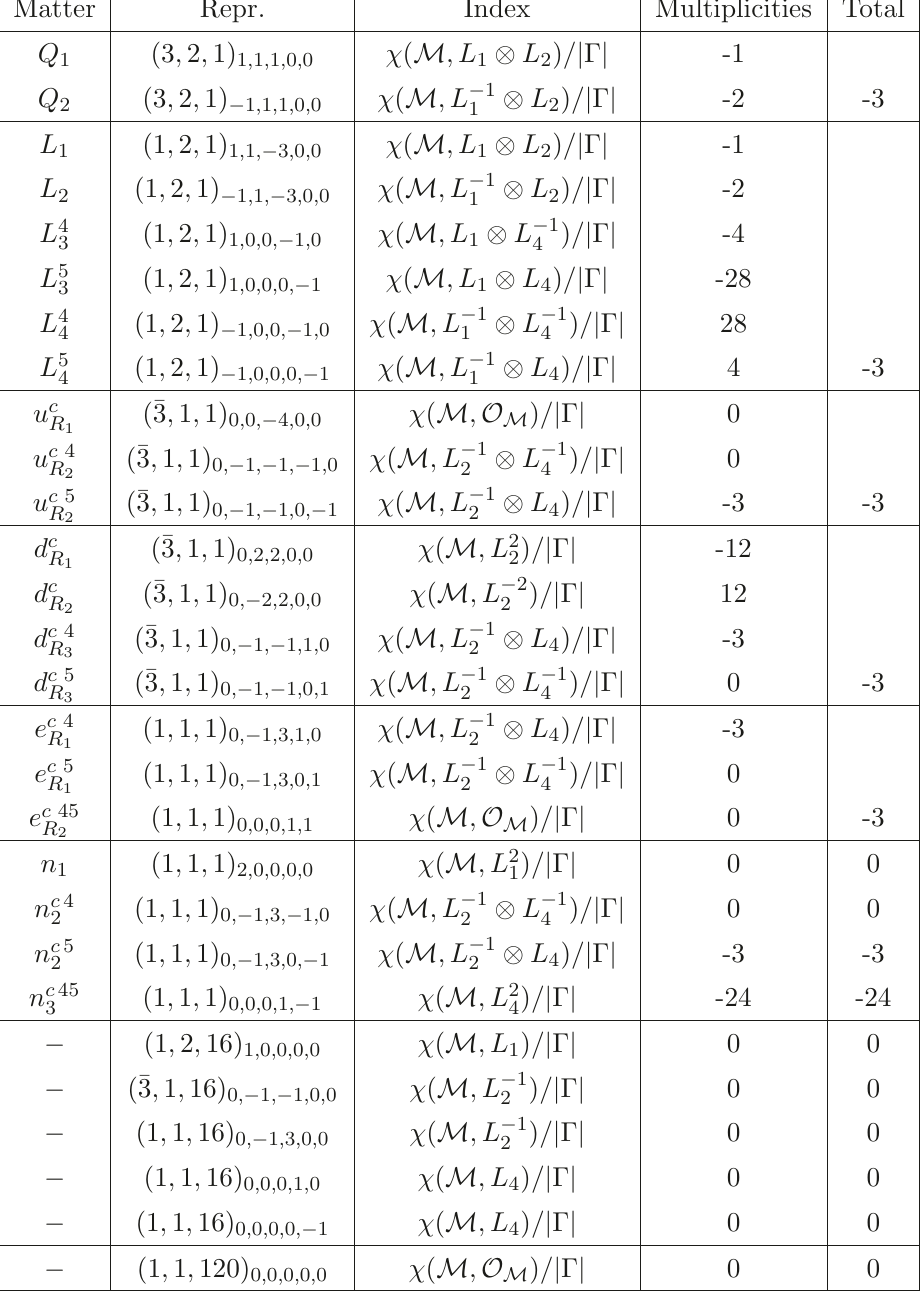
Supersymmetric spectrum in visible and hidden sectors for the line